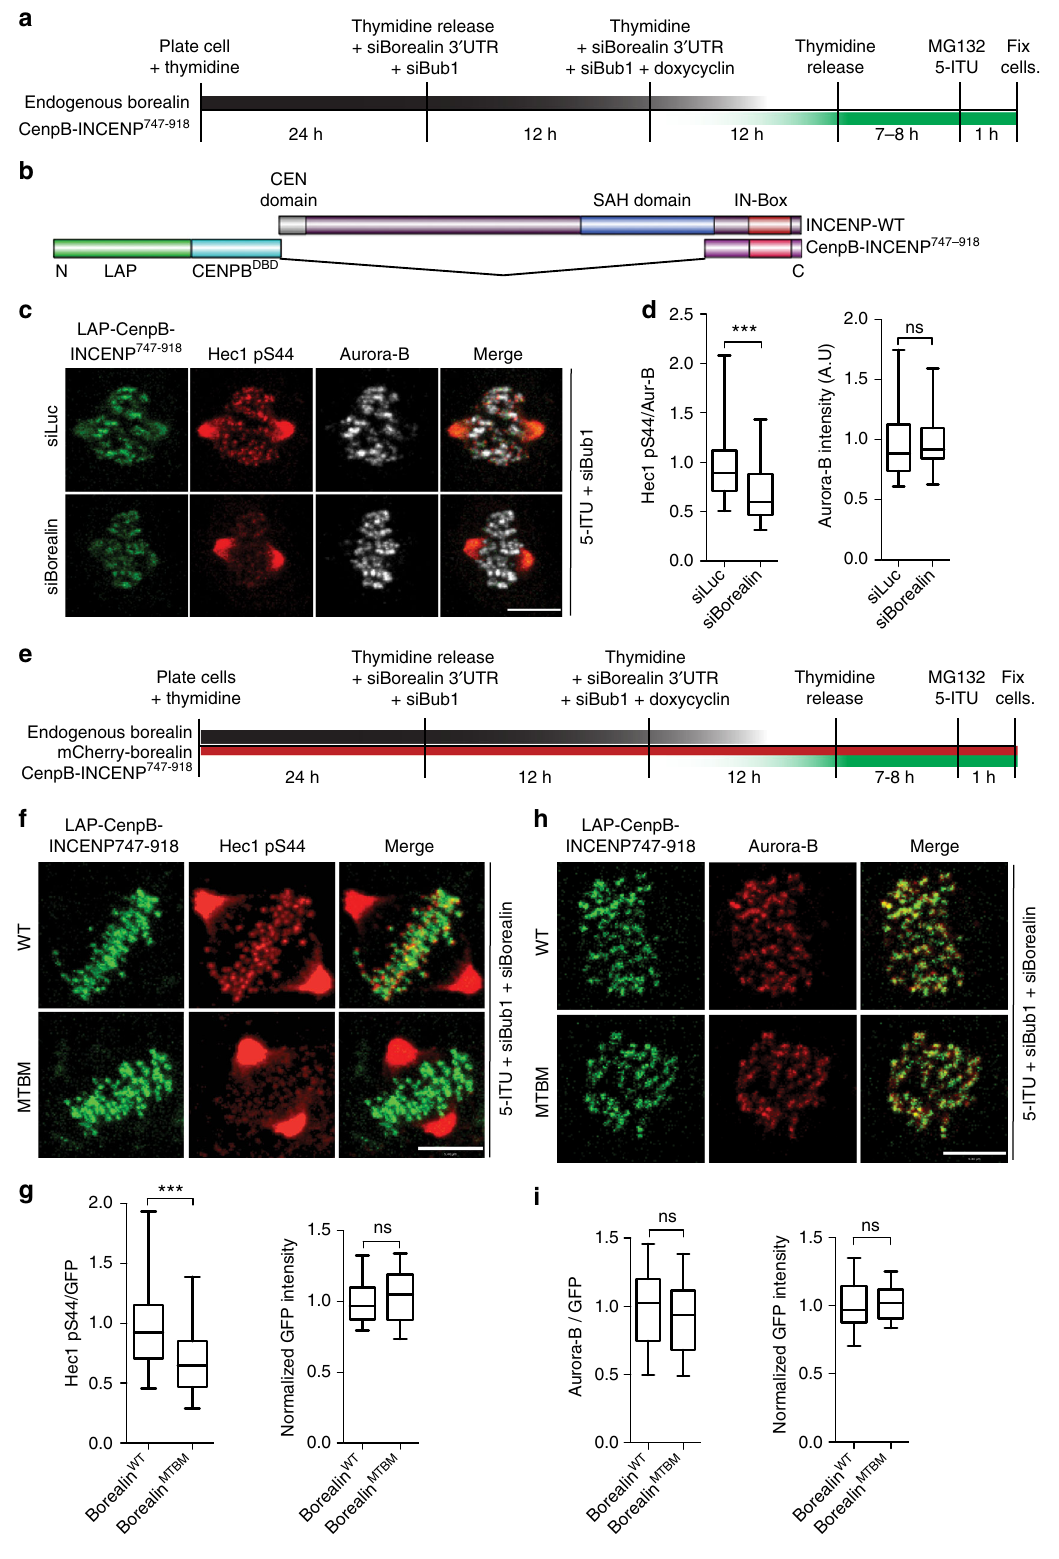
kinetochore substrates. Second, this kinetochore phosphorylation affects the Bub1-Sgo1-CPC localization pathway increasing the amount of CPC in the inner